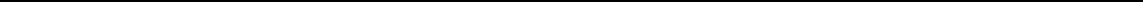
Fig. 5 DDR signaling is involved in FUS-NLS pathophysiology. a IF of SOX2 staining (green) validated NPC identity for DSB counting (by γ H2AX, red) in ( c ). b DNA DSBs in iPSC-derived FUS R521C spinal MNs (right) versus WT control cells (Ctrl1 left, Table 1) by ICC for nuclear γ H2AX foci (red) at 14 and 30 DIV, bar: 10 µ m. More DSB foci (white arrowheads) were observed in FUS mutants (right) already at 14 DIV and increased in controls (left) and FUS mutants after Etoposide treatment. In addition, cytoplasmic FUS inclusions in FUS mutants increased after etoposide treatment (green, hollow arrowheads). c , d Both, FUS- NPCs ( c ) and mature – MNs ( d ) showed more DSBs per nucleus over controls ( N = 3). e Untreated mature FUS-GFP P525L (FUS) MN showed increased nuclear DSB foci over isogenic control cells, consistent with untagged FUS lines in ( d ). 1 h etoposide treatment and 24 h withdrawal led to a similar response compared to control cells (i.e. transient increase of DSB foci and reversion to basal levels indicative of successful DSB repair). f Same as e but expressed as fold change over respective untreated control ( N = 4). Statistics c – f : data are plotted as mean, unpaired t -test (only c ) or one-way ANOVA ( d – f ) with post- hoc Bonferroni test (*, **, *** P values of 0.05, 0.01, and 0.001, respectively, error bars = STDEV). g Validation of the anti- γ H2AX antibody in FUS-GFP P525L MNs (without etoposide) by costaining with anti-53BP1, a second marker for DSBs. Note the prominent colocalization (merge, yellow overlapping). h Live imaging of MN at 21 DIV shown as maximum intensity projections: distal loss of organelle motility and mitochondrial membrane potential in FUS mimicked through proximal etoposide or arsenite addition to control, bar: 10 µ m (Supplementary Movies 4, 5). i – m Organelle tracking ( i , j ), mitochondrial membrane potential ( k ) and shape ( l , m ) analyses of ( h ) as box plots, batch analysis of Ctrl1-3 (Ctrl) and FUS R521C, R521L, R495QfsX527 (FUS) as described in Table 1, exception: arsenite treatment only on FUS corrected R521C (FUS-GFP WT). n ICC showing augmented DSBs ( γ H2AX) in ALS-FUS case over healthy control person, bar: 20 µ m. o ICC showing FUS aggregation in the cytoplasm (white arrows) of a typical ALS-FUS case with R521C mutation (mid gallery row) in the NLS along with augmented γ H2AX occurrence in the nucleus (gray arrows) as opposed to an atypical, peculiar case (Y526C, bottom gallery row) with cytoplasmic co-aggregation of FUS and γ H2AX (yellow arrow), bar: 20 µ